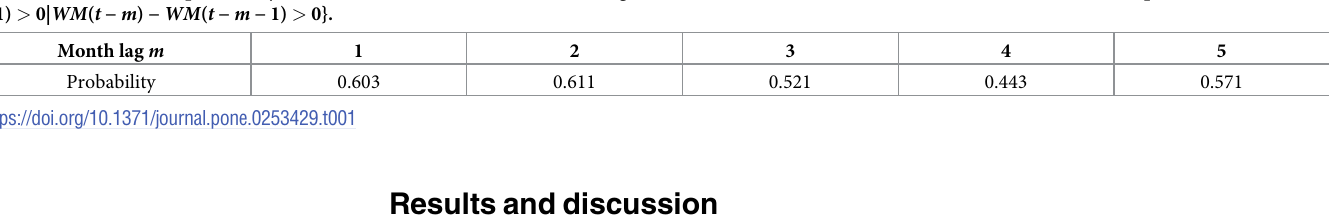
Table 1. The conditional probability that the adult/sow PRRSV rate increases given that the wean-to-market PRRSV rate increases m months prior: P { AS ( t ) − AS ( t